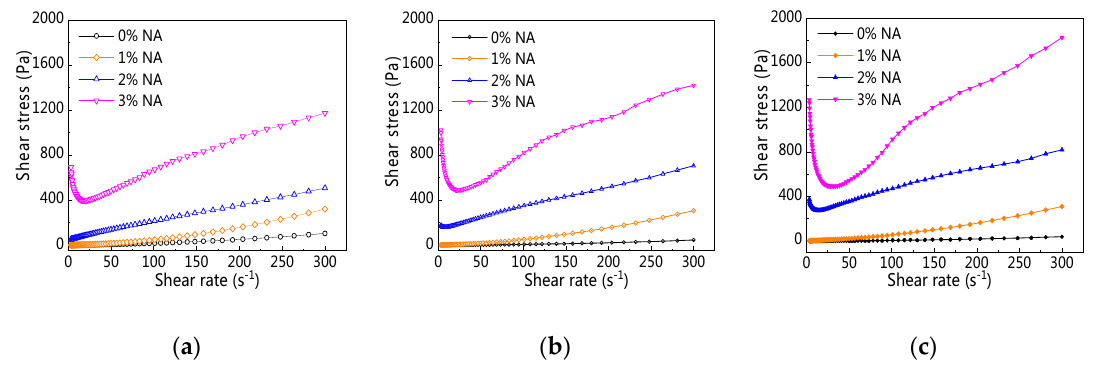
Figure 22. Rheological curve of C–FA paste with nano-Al 2 O 3 (NA) at different resting times. ( a ) 5 min; ( b ) 60 min; ( c ) 120 min.